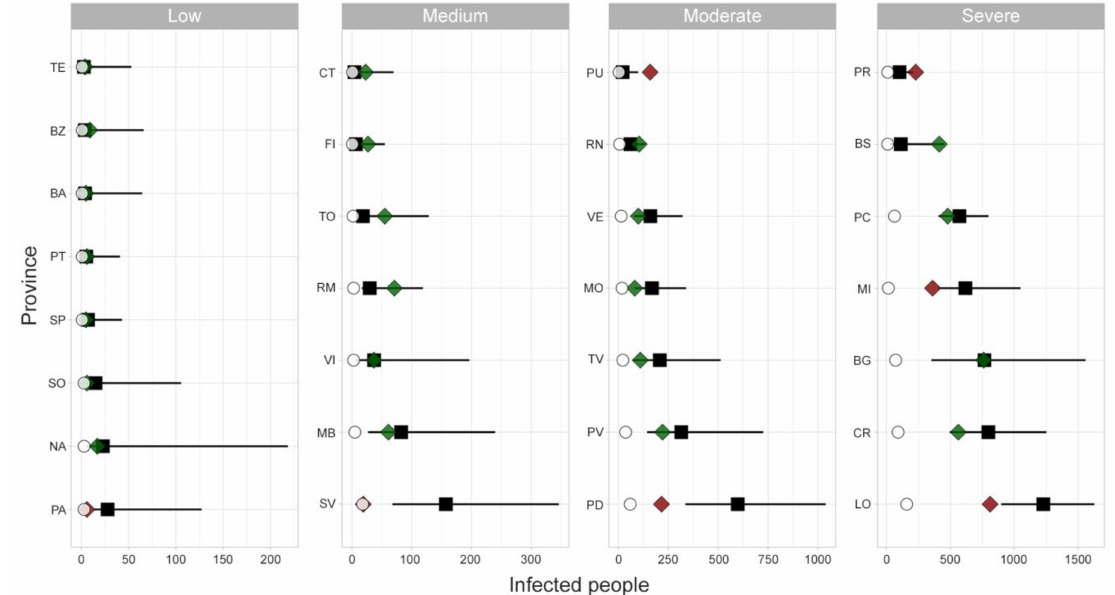
Figure 12. Infected people in seeding provinces as of March 6. Black squares represent median values, lines the 95% confidence interval (CI), green and red diamonds represent observed data within (green) and outside (red) the CI, while white dots represent the observed cases as of February 26. The panels’ order (from low to severe level of infected people) is used for displaying